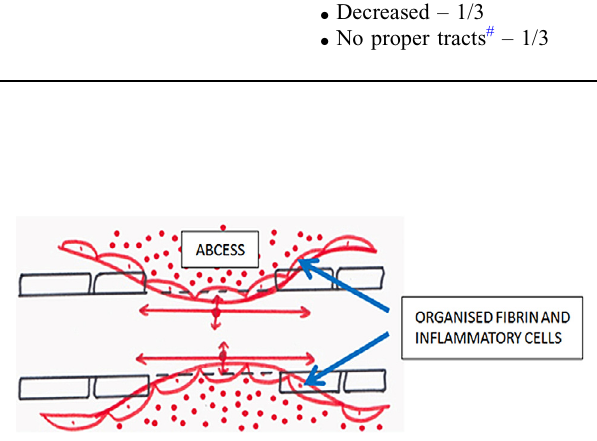
Figure 5. Effect of abscess and organized inflammatory cells on diffusion, thereby maintaining